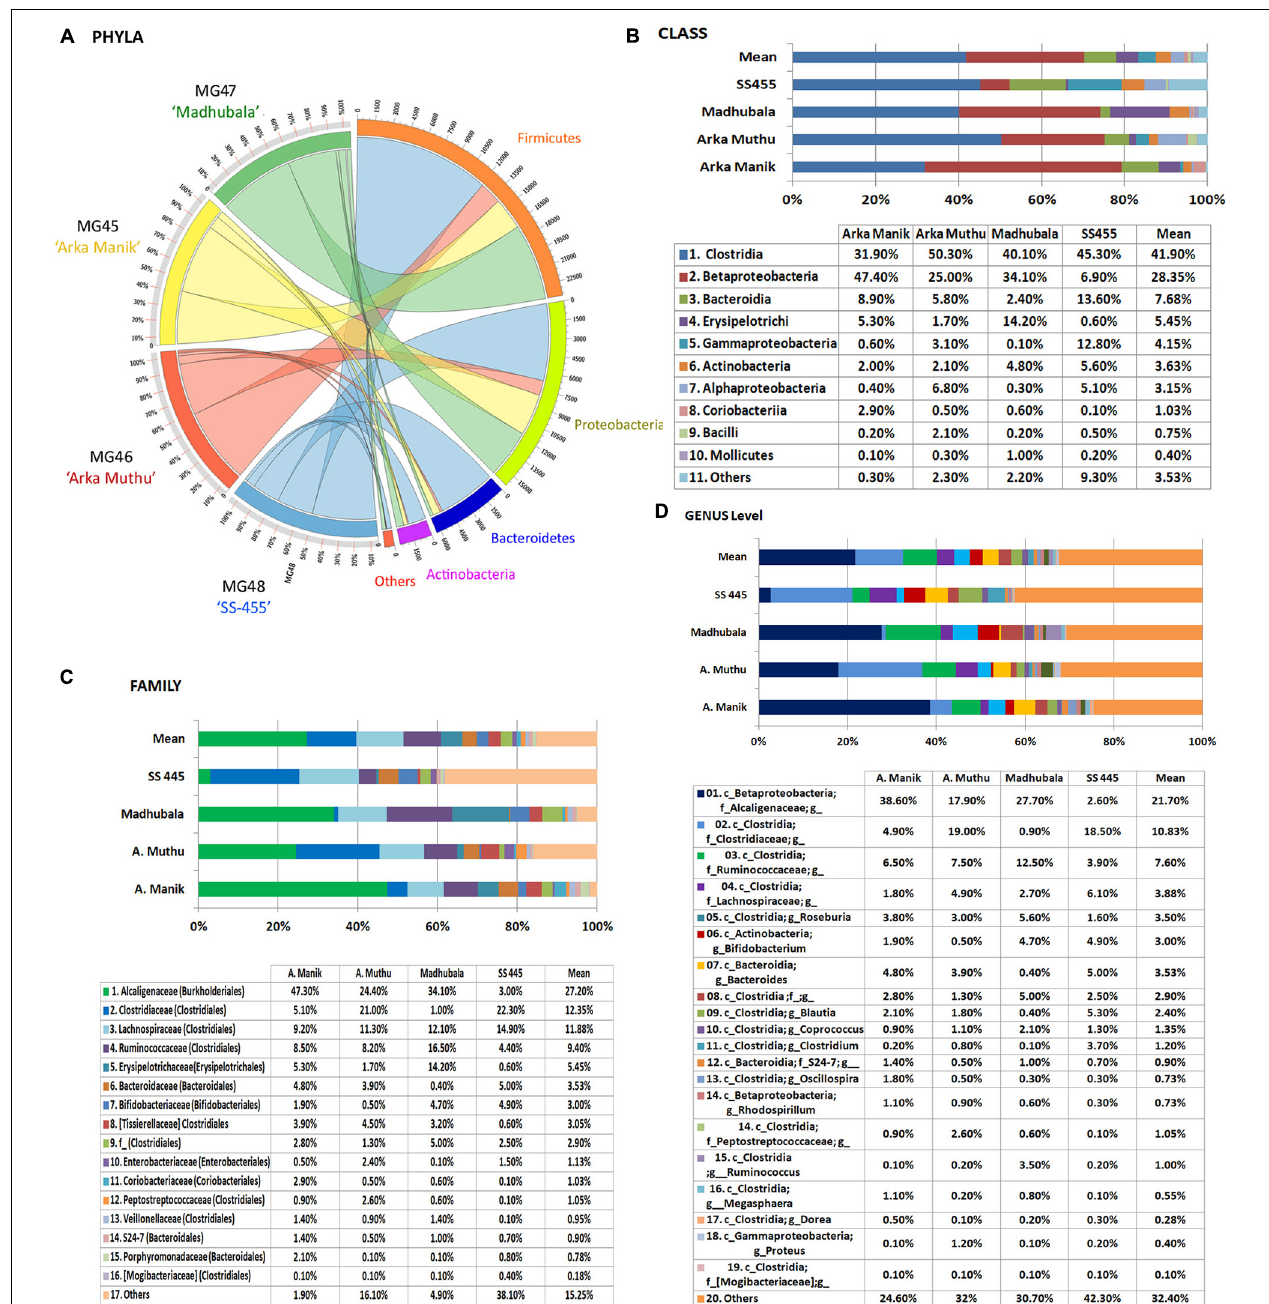
FIGURE 6 | Distribution of phylogenetic groups as per 16S rRNA metagene V3–V4 region taxonomic profiling of DNA derived from the surface-sterilized seed embryos of four watermelon cultivars at phylum (A) , class (B) , family (C) , and genus (D)